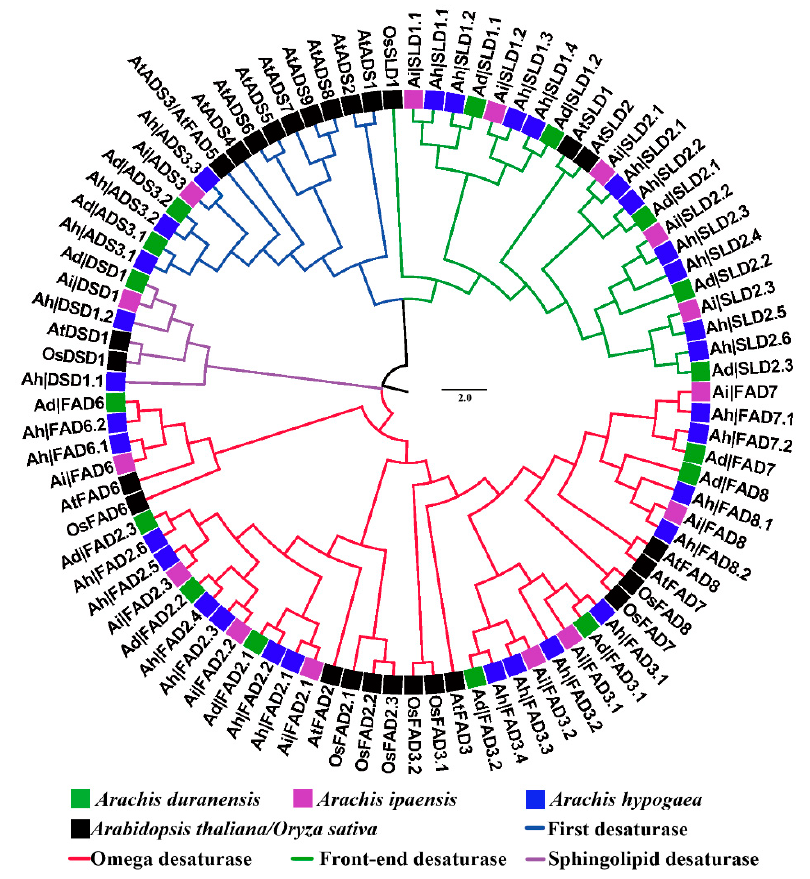
Figure 1. Phylogenetic tree of FAD genes from three peanuts species, Arabidopsis thaliana , and Oryza sativa .